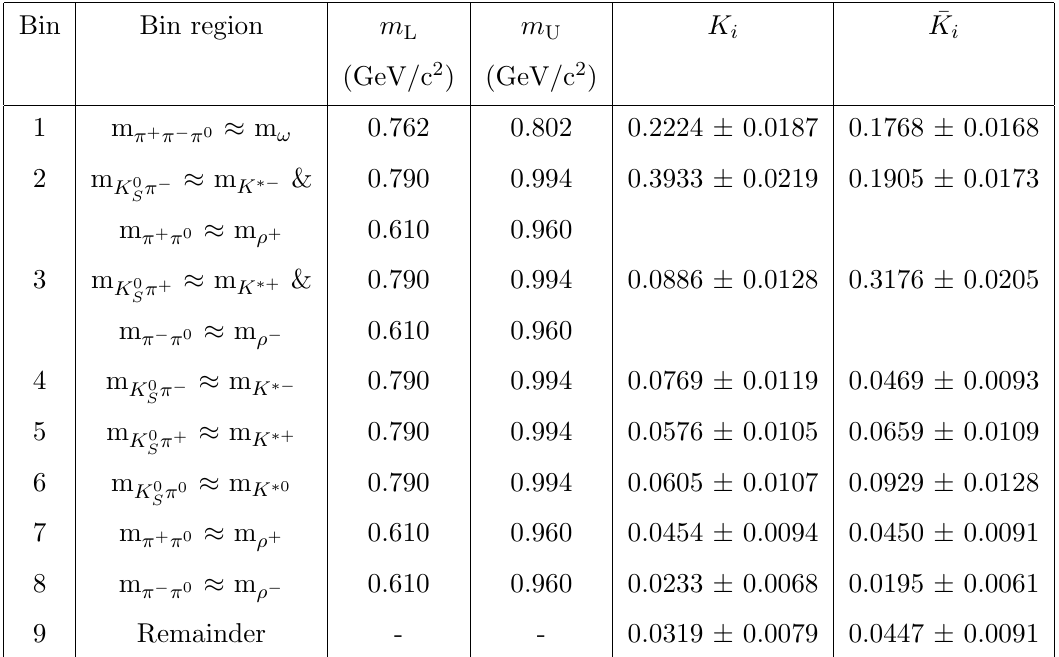
Table 6 . Speci(cid:12)cations of the nine exclusive bins of D ! K 0 fraction of (cid:13)avour-tagged D 0 and (cid:22) D 0 events in each of them. m L and m U are the lower and upper limits, respectively, of the invariant masses in each